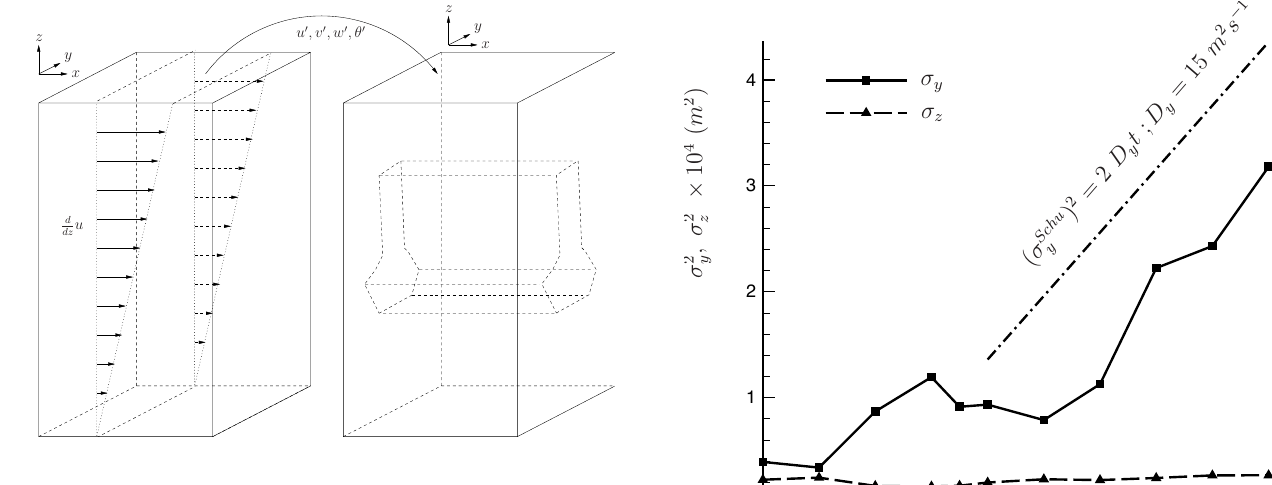
Fig. 14. Sketch of the method used to force turbulence during the late dissipation regime. Anisotropic turbulent fluctuations are generated in the left (‘father’) domain by a synthetic shear that mimics atmospheric turbulence. These fluctuations are then fed into the right (‘son’) domain containing the contrail using Eqs. 19-22. Fig. 15. Evolution of contrail horizontal σ y and vertical σ z spreads